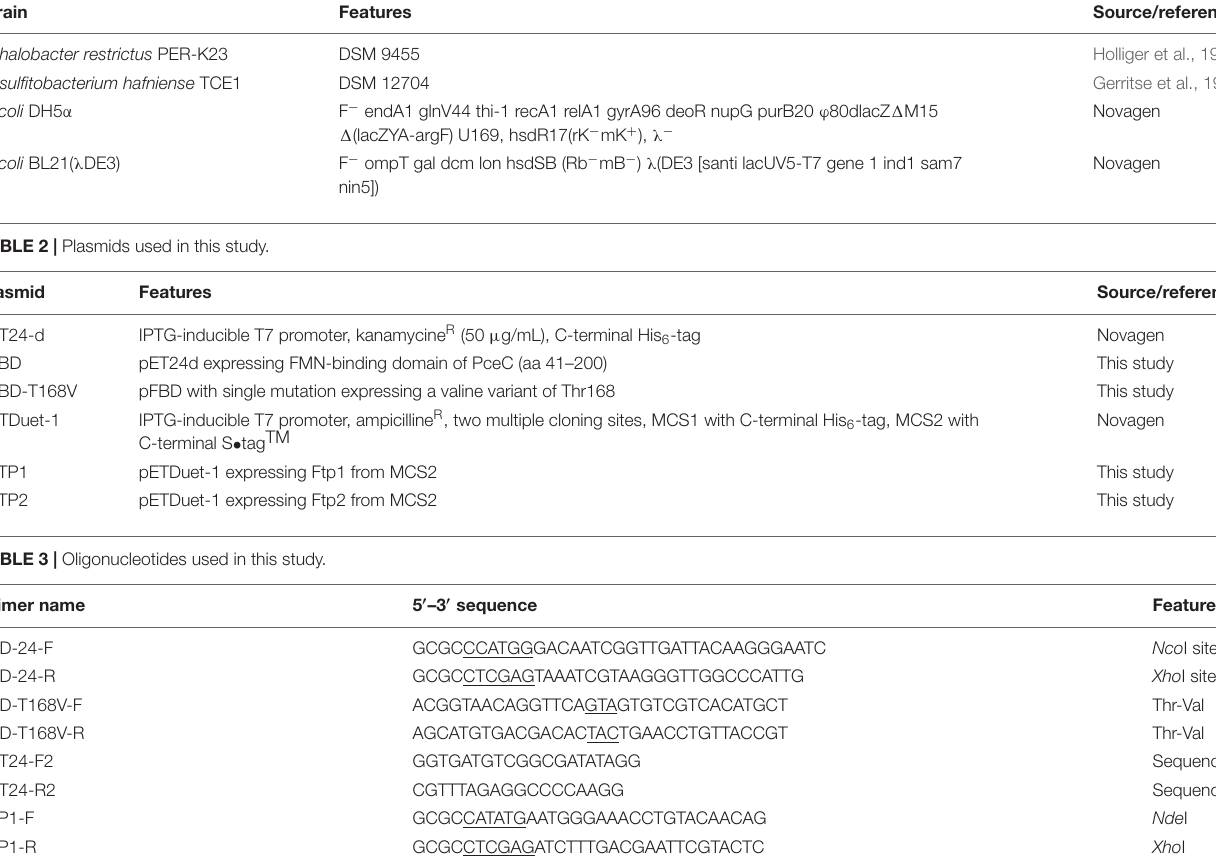
TABLE 1 | Bacterial strains used in this study.